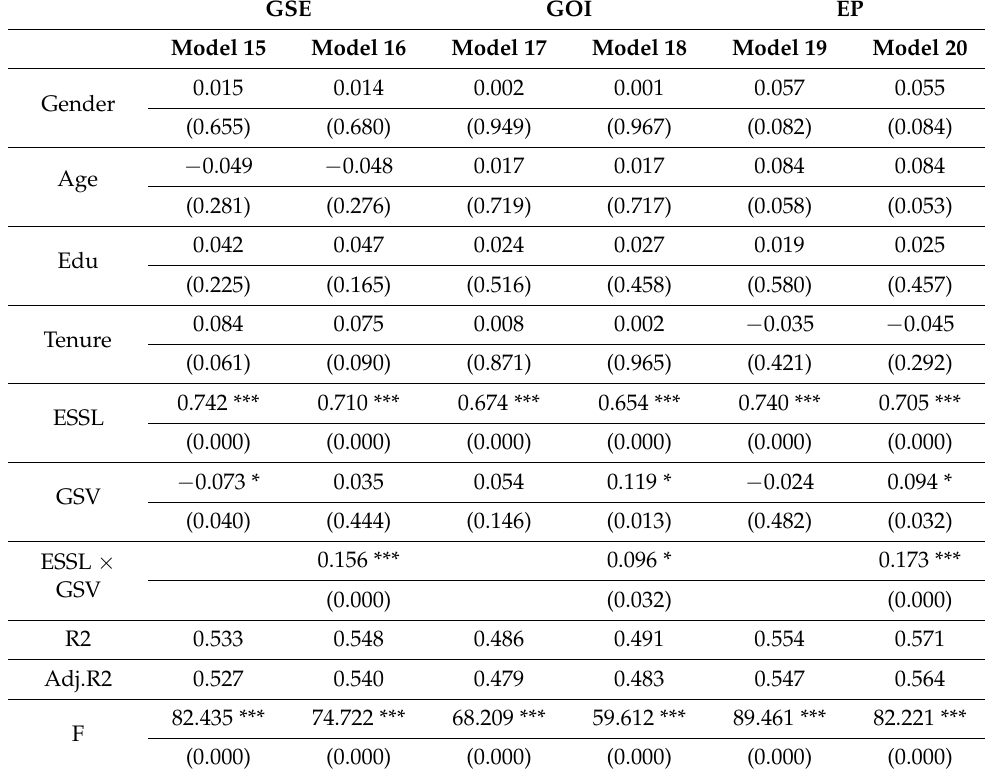
Table 5. The moderating effect of GSV.